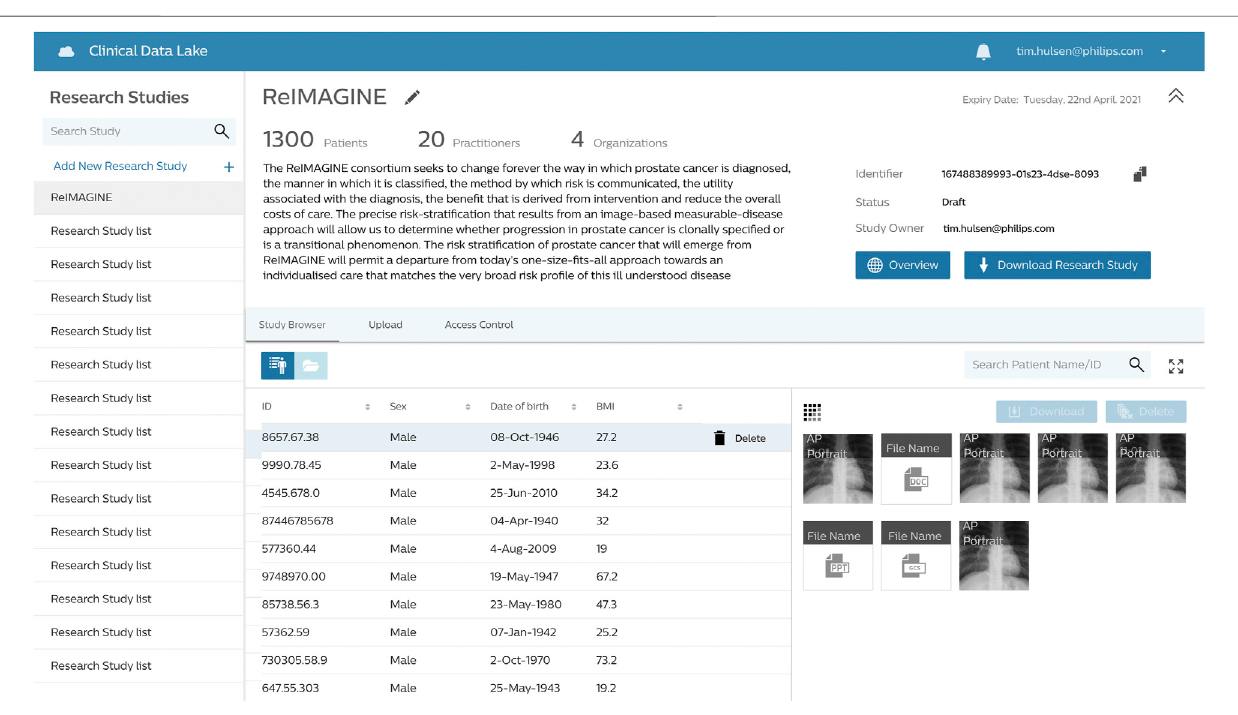
( Figure 3 ) is organized using several levels: work strand, data type and subject. Data from each workstrand is uploaded